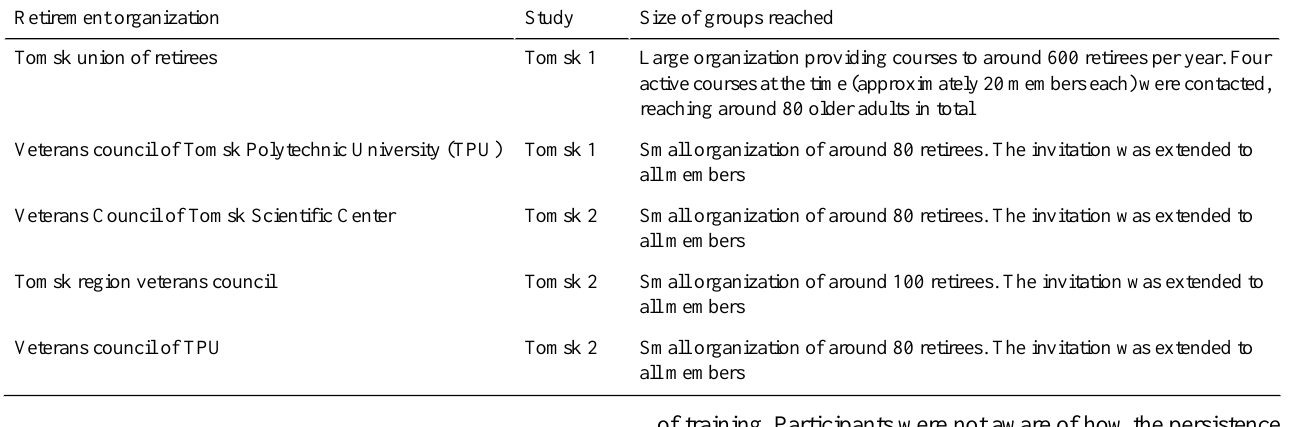
Table 3. Senior citizen organizations contacted and candidates reached in each